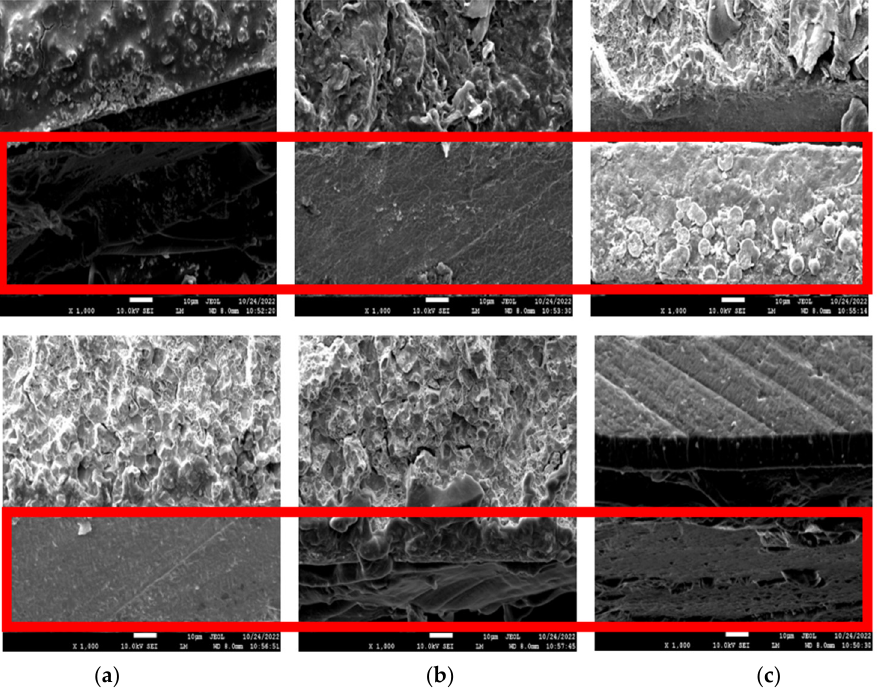
Figure 5. Cross-sectional SEM images of ( a ) WPU − g − BTA − A, ( b ) WPU − g − BTA − B, and ( c ) WPU − g − BTA − C in before corrosion (top) and after corrosion (bottom) in 3.5 wt% NaCl (aq) after 3 days of immersion.